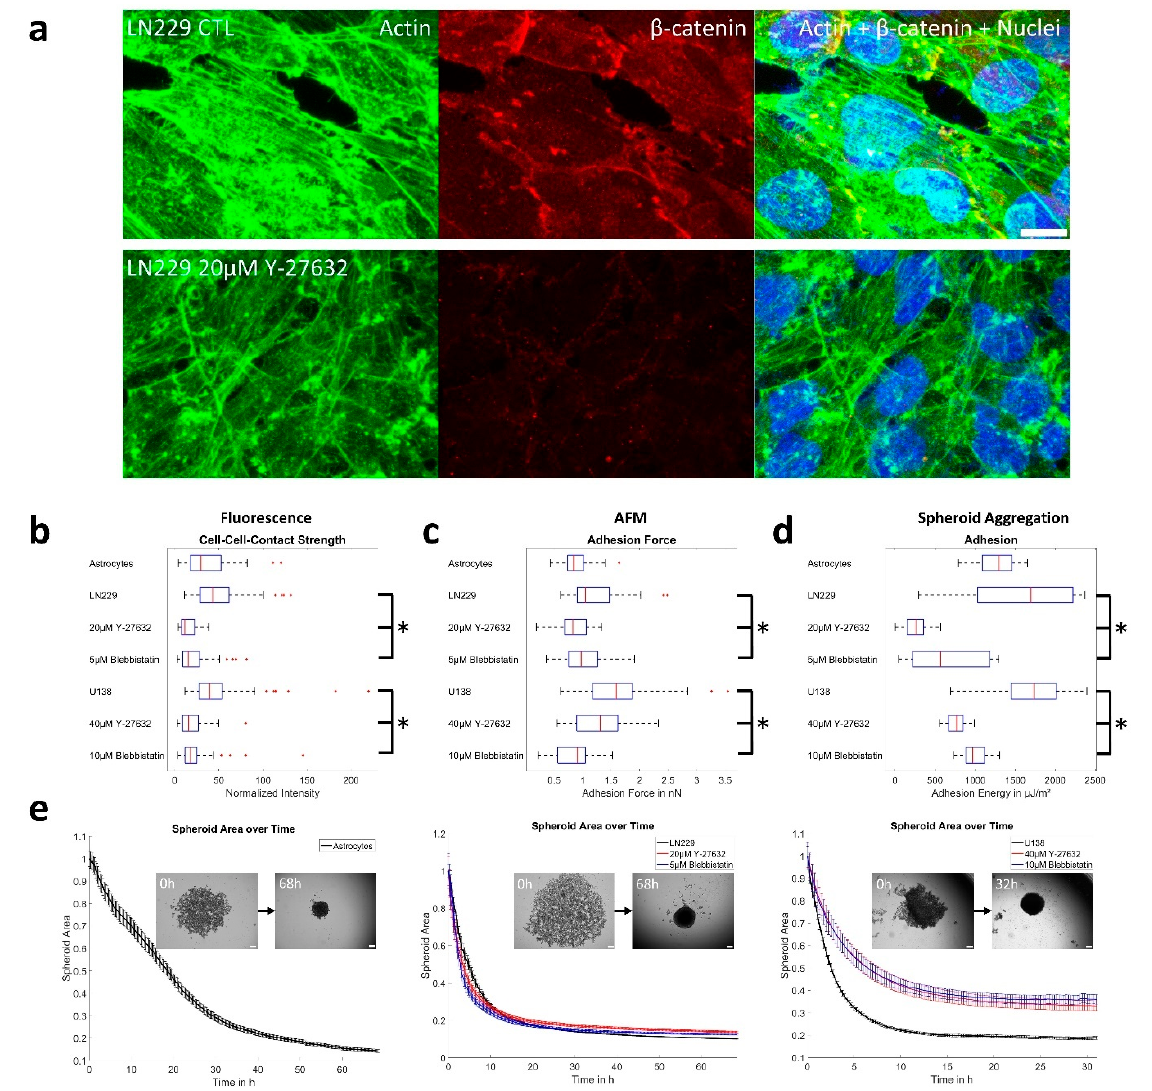
Figure 7. ( a ) Representative examples of actin and β -catenin staining for LN229 cells. Scale bar depicts 10 µ m. ( b ) Cell–cell adhesion strength as estimated by the fluorescence images. For all statistically significant differences: p < 0.0001. For astrocytes 73 cell–cell connections were measured. For LN229 70, 49 or 72 and for U138 75, 74 or 67 cell–cell junctions were analyzed for control conditions or when treated with Y-27632 or blebbistatin, respectively. ( c ) Cell–cell adhesion forces as measured using AFM. For LN229 treated with Y-27632 and U138 treated with blebbistatin p < 0.01, p < 0.05 otherwise. The sample size for astrocytes was 30, for LN229 39, 35, 34 and for U138 32, 27, 26 for control conditions or after treatment with Y-27632 or blebbistatin, respectively. ( d ) Values calculated for the cell–cell-adhesion energies obtained from the spheroid aggregation. p < 0.0001 for all significantly different treatments, as assessed by one way ANOVA with Tukey post hoc test. For astrocytes 46 spheroids were assessed. For LN229 31, 23 or 17 and for U138 cells 33, 39 or 27 spheroids were measured for control conditions or Y-27632 or blebbistatin treatment, respectively. ( e ) Evolution of the spheroid area over time for astrocytes and both GBM cell lines for all used conditions. Inlets show typical spheroids at the beginning and end of the measurement. Sample size is identical to d. Scale bars depict 300 µm. ( b – d ) Box plots show the median (red line), 25 and 75 percentile (box), non-outlier range (whiskers) and outliers (red dots). ( e ) Error bars depict the standard error of the mean. Stars (*) depict statistically significant results.